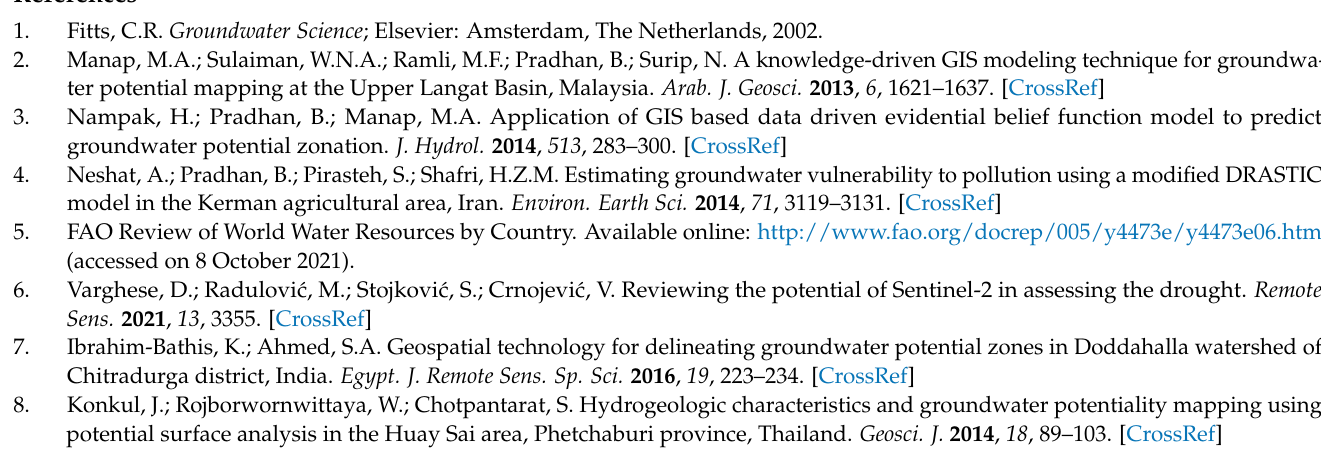
geomorphology, Table S2: The pairwise comparison matrix for geology, Table S3: The pairwise comparison matrix for land use/land cover, Table S4: The pairwise comparison matrix for drainage density, Table S5: The pairwise comparison matrix for slope, Table S6: The pairwise comparison matrix for soil, Table S7: The comparison of normalized AHP and normalized FAHP